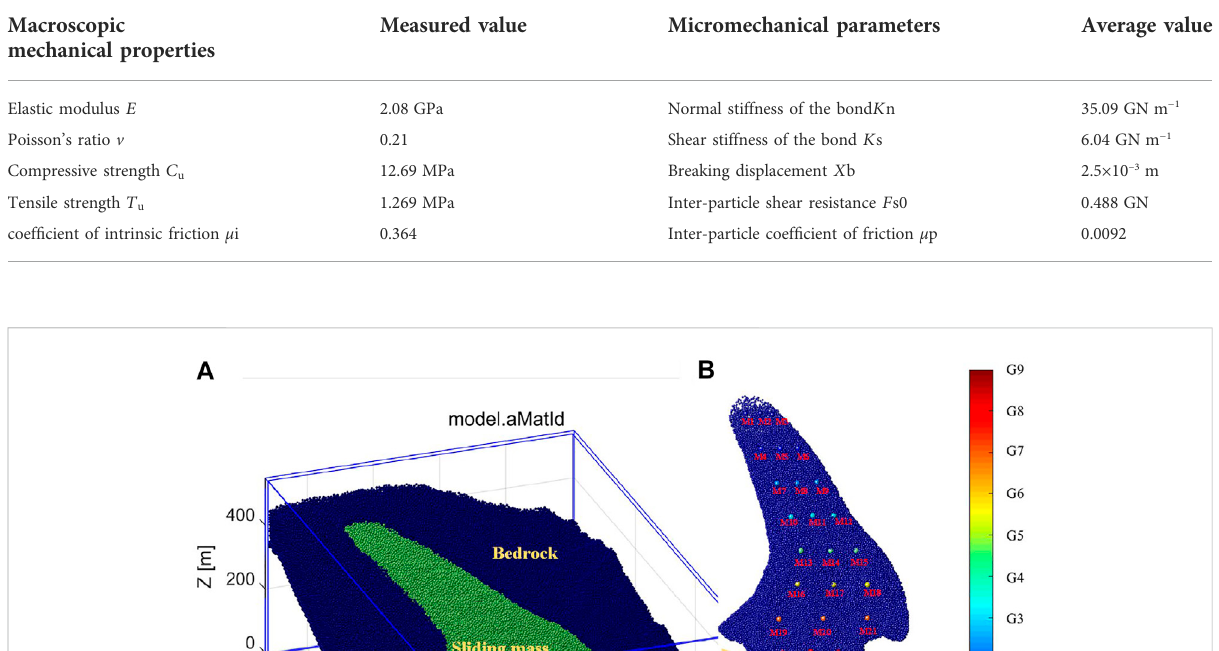
TABLE 2 Macro and micro parameter values of sliding mass material.